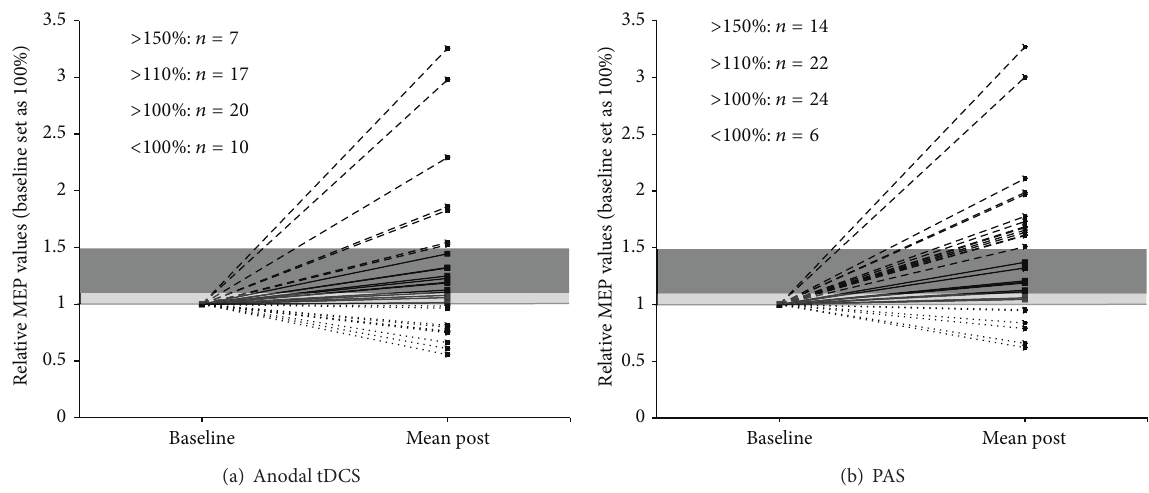
Figure 4: Presentation of the number of responders to (a) anodal tDCS and (b) PAS within the three different response ranges scaled in relative values, with 1 representing 100% of baseline MEP size. The > 100% cut-off range is depicted in light grey and the > 110% range in dark grey. Responders over 150% are shown above the dark grey bar and nonresponders (NR) underneath the black line representing 100% baseline MEP. Total numbers shown for each of the separate cut-off